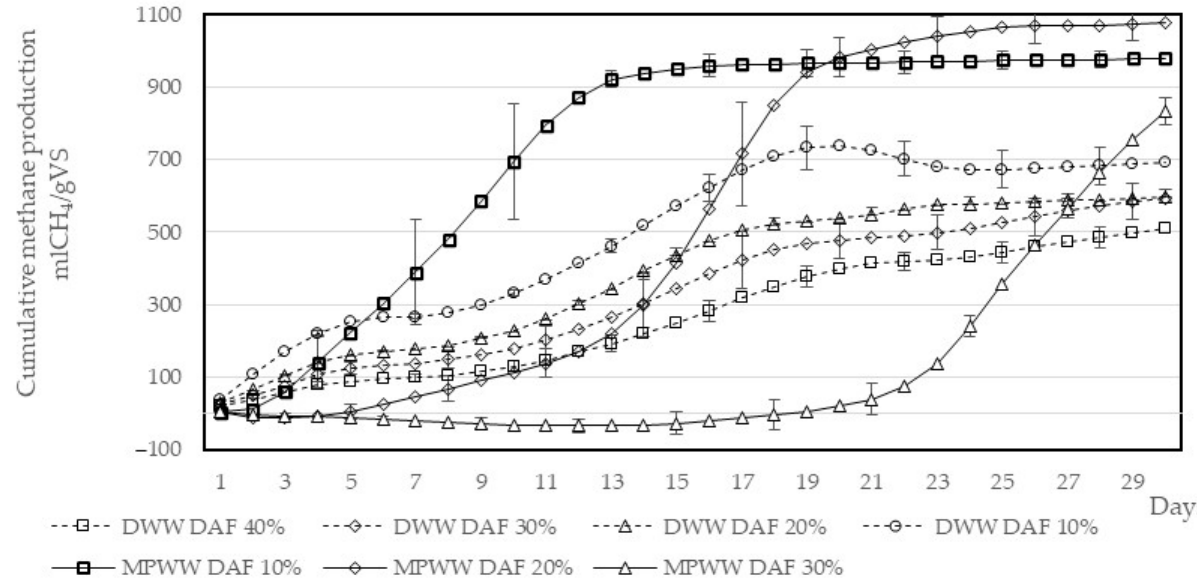
Figure 5. Meat and dairy processing wastewater FOG cumulative biomethane outcome in 30 days with different sludge loads from inoculum VS.